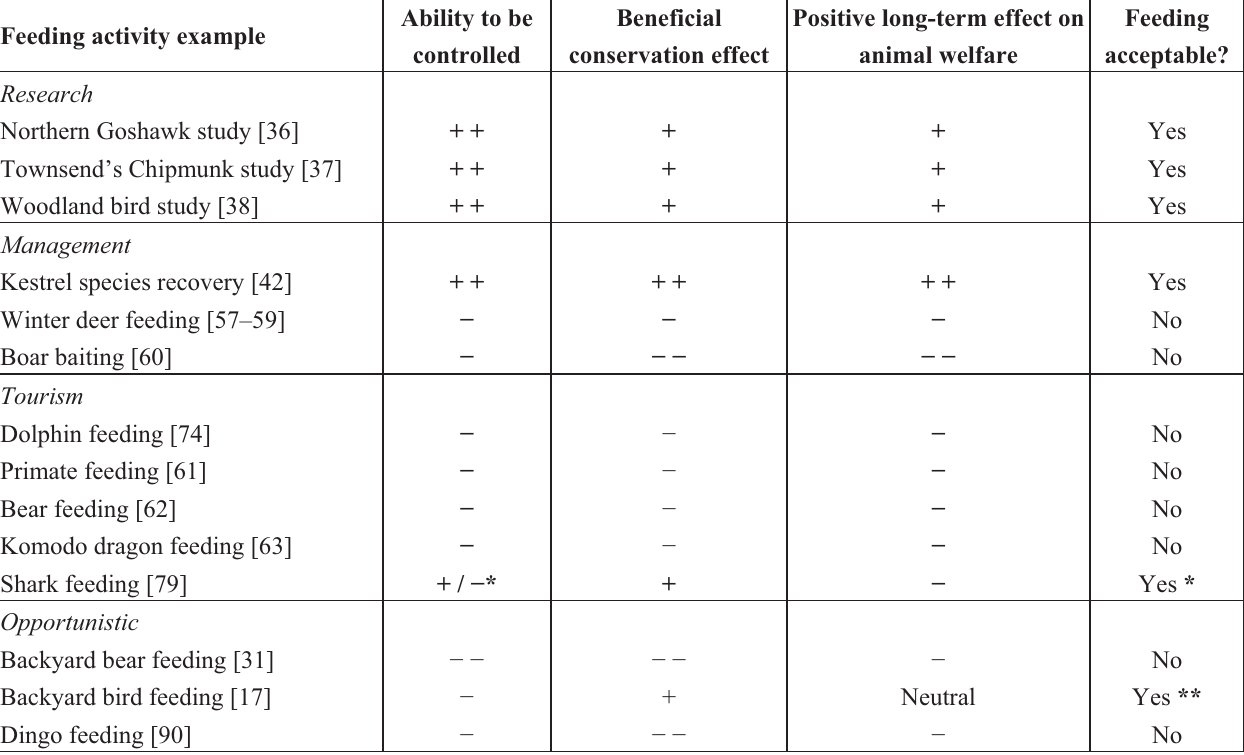
Table 2. Application of the wildlife feeding acceptability framework to reported examples of wildlife feeding based on their ability to be controlled, have beneficial effects on conservation and have a positive long-term effect on animal